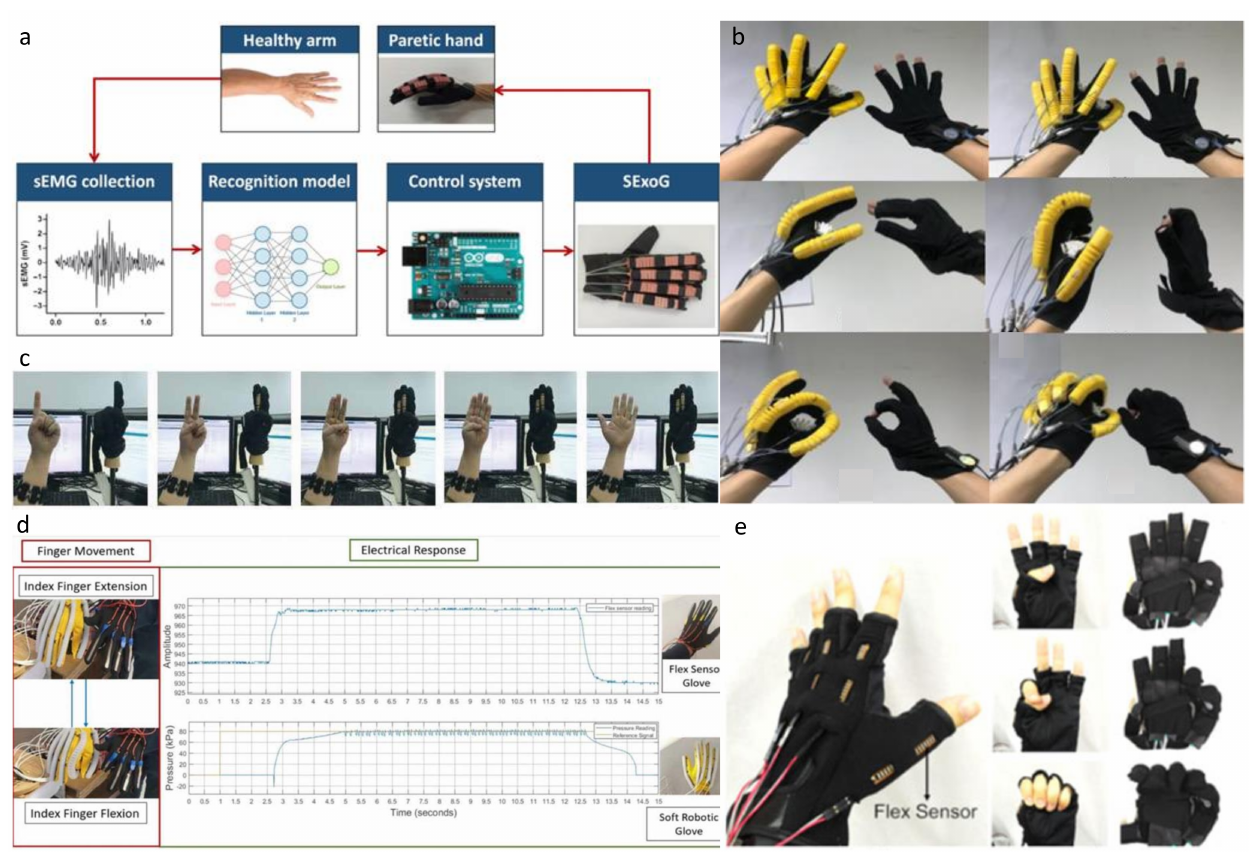
Figure 23. Rehabilitative Systems for bilateral training and mirror therapy. ( a ) SExoG developed by Chen et al. [65] for bilateral training with sEMG signals. ( b ) Rehabilitation system for mirror therapy developed by Li et al. [30], based on 3D-printed soft actuators. Reprinted/adapted with permission from Ref. [30]. 2020, IEEE. ( c ) Hand rehabilitation system for mirror therapy. The possible hand gestures are classified with a ML algorithm based on ANNs. Reprinted/adapted with permission from Ref. [65]. 2020, IEEE. ( d ) Soft gloves developed by Gerges et al. controlled with sEMG signals, for mirror therapy implementation. Reprinted/adapted with permission from Ref. [66]. 2020, IEEE. ( e ) Fully fabric-based bidirectional soft robotic glove controlled by the signals of flex sensors in a data glove worn on the healthy hand, for bilateral training, developed by Yap et al. [67]. Reprinted/adapted with permission from Ref. [67]. 2017,